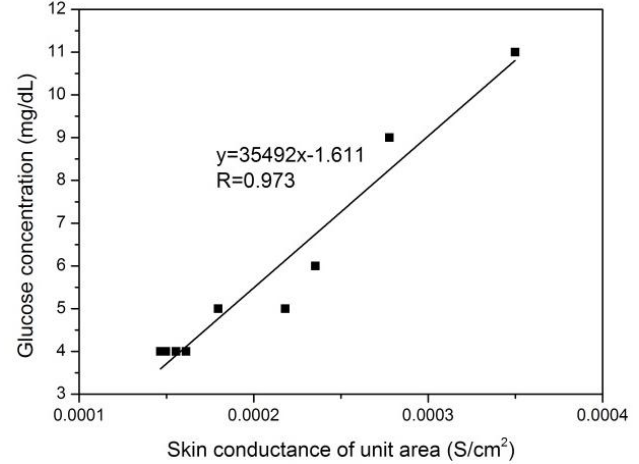
Figure 7. Relation between the glucose concentration of the sample solution and skin